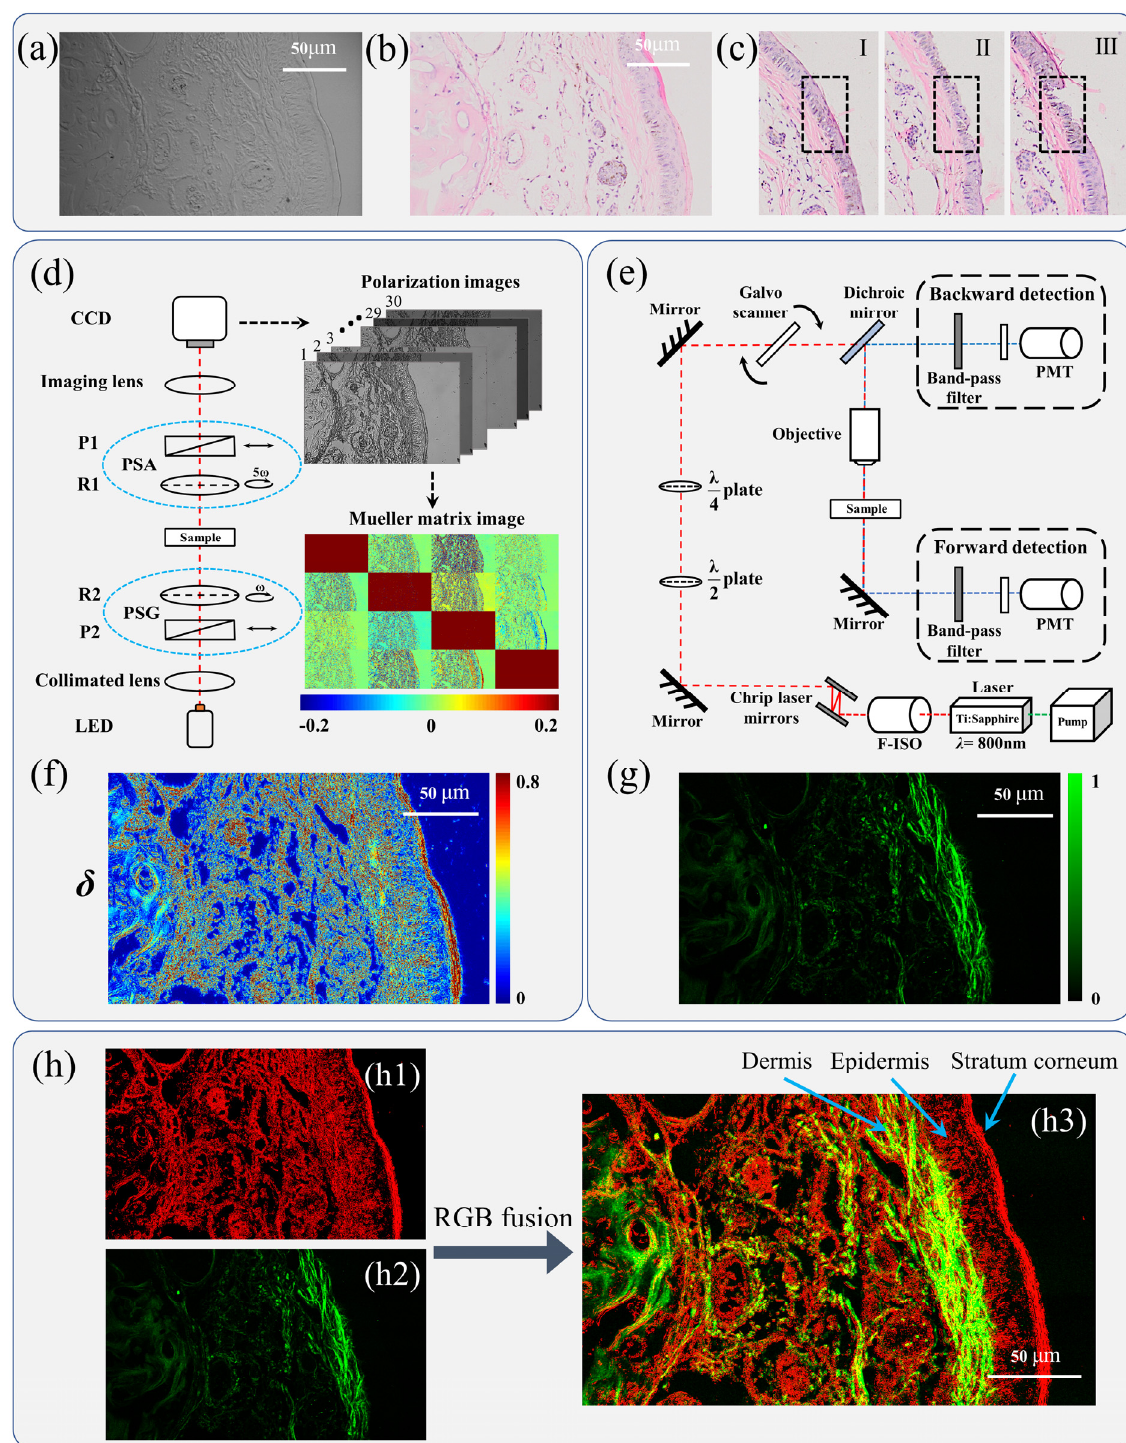
Figure 1. Schematics of skin tissue samples and experimental setups: microscopic images of mouse tail skin tissues for ( a ) the unstained slice, ( b ) the corresponding H&E-stained slice using a 20 × /0.75 NA objective (UPlanSApo, Olympus, Tokyo, Japan); ( c ) H&E-stained tissue sections with damage areas in different layers indicated by dashed boxes, I: stratum corneum layer, defined as having a depth of less than 40 µ m damage with partial loss of the stratum corneum layer, II: stratum corneum and epidermis layers, defined as having a depth between 40 and 140 µ m damage, with complete destruction of the stratum corneum layer and partial destruction of the epidermis layer, III: